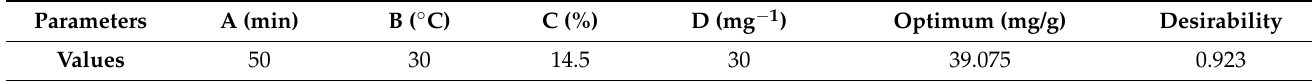
Table 3. Optimum conditions of the variables that maximize the response values using RSM.